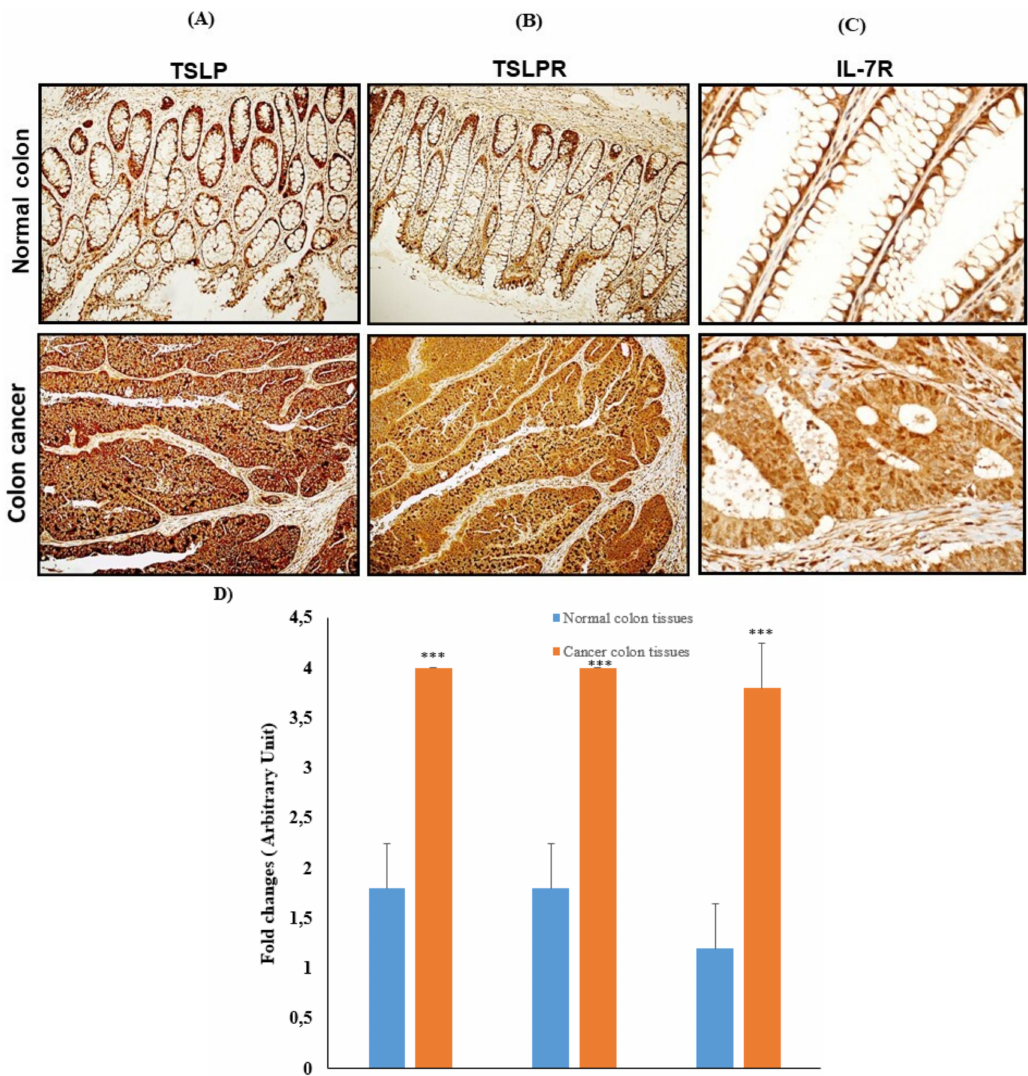
Figure 2. IHC array analyses for TSLP and TSLPR- α , and IL-7R- α in matching normal and colon cancer tissues. Protein levels of ( A ) TSLP, ( B ) TSLPR- α , and ( C ) IL-7R- α in colon cancer tissues compared to normal colon tissues by using a specific antibody for each gene. ( D ) Summary of TSLP, TSLPR and IL-7R expression on normal and colon cancer tissues. Positive cells in the tissues were estimated as follows: Positive staining was estimated as follows: no positive color (0 points), <20% positive staining (1 point), 21–50% positive staining (2 points), 51–75% positive staining (3 points), >75% positive staining (4 points). *** p <